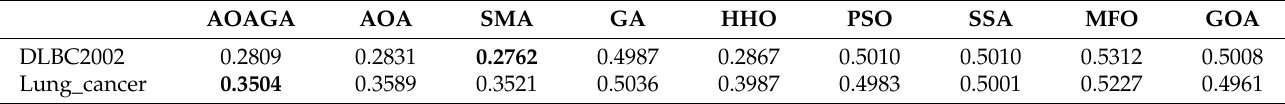
Table 15. Real Application: Ratio of the selected